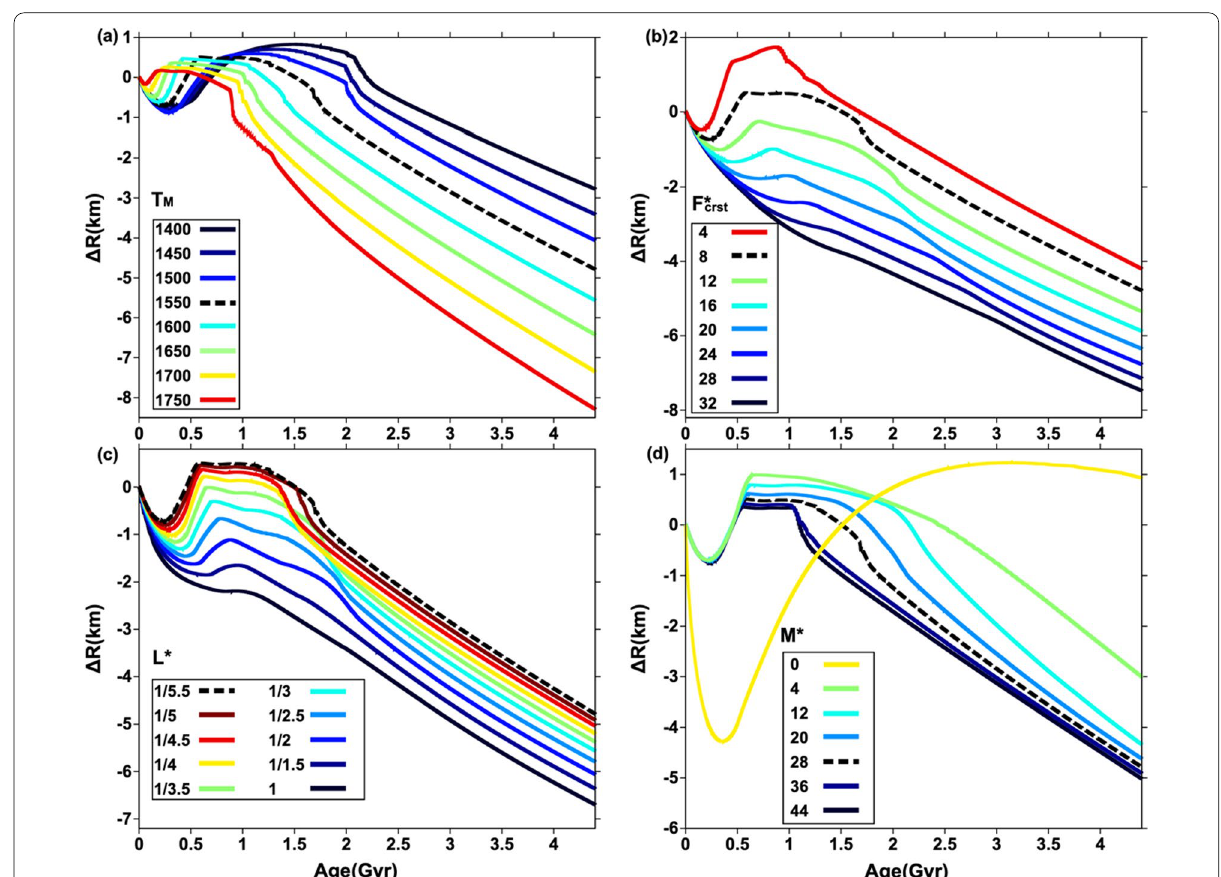
Fig. 6 Radial change at various free parameters. Plots of radial change against time calculated at various values of a T M , b F ∗ crst , c L ∗ , d M ∗ . The dotted lines show the reference model indicated by the purple line in Fig. 2a